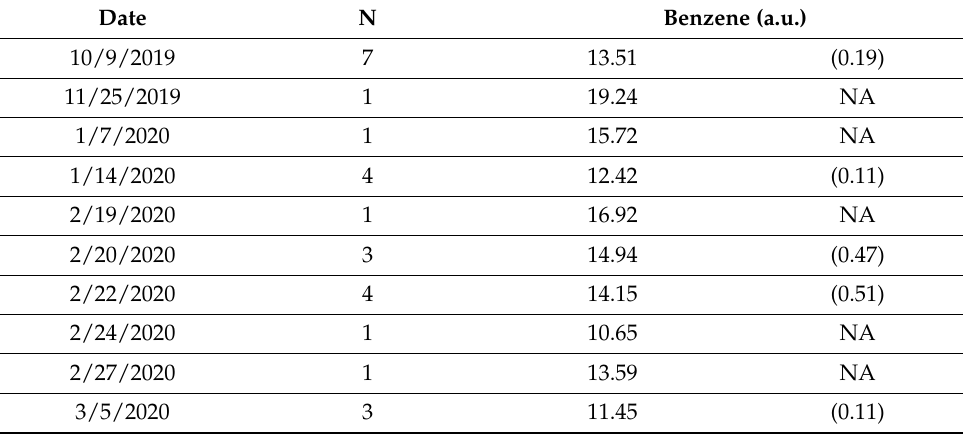
Table 4. Drift experiments using a 1 ppb BTEX gas standard organized by date. Observed benzene reported in area units (a.u.). For dates where number of 1 ppb gas standard samples (N) were > 1, the standard deviation is shown in